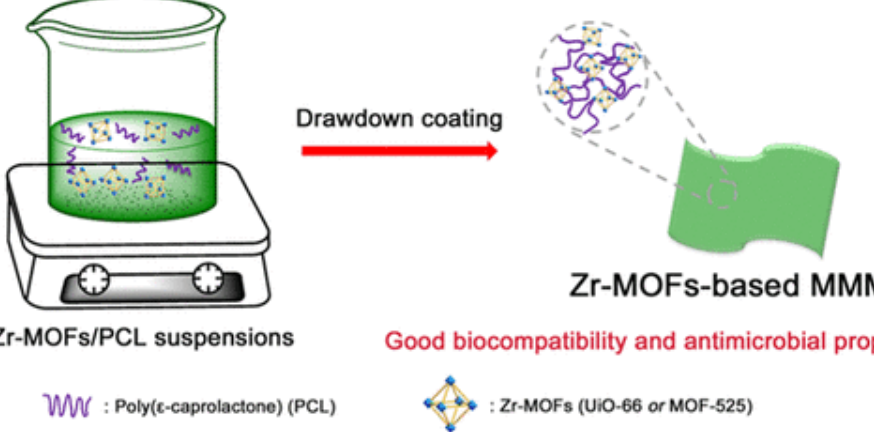
Figure 19. Scheme showing synthesis of mixed matrix membranes of poly( ε -caprolactone) and MOFs (UiO-66 and MOF-525). This scheme shows the synthesis method of Zr-MOF-based MMMs; a heated suspension of MOFs in PCL solution is then casted onto cover slides and left to dry, yielding antimicrobial MOF polymer composites. Reproduced with permission from [177] .